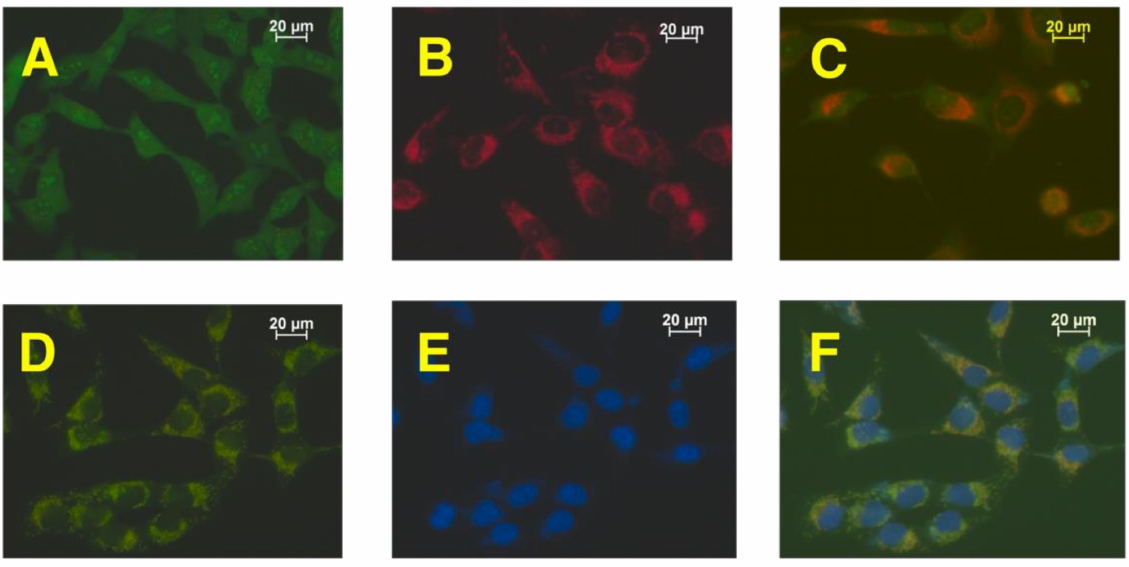
Figure 2. Staining experiments: A375 cells, 24 h; ( A ) control (AO); ( B ) in the presence of 26 ; ( C ) merged (AO, 26 ); ( D ) control (AO); ( E ) Hoechst 33,342 staining; ( F ) merged (Hoechst 33,342).